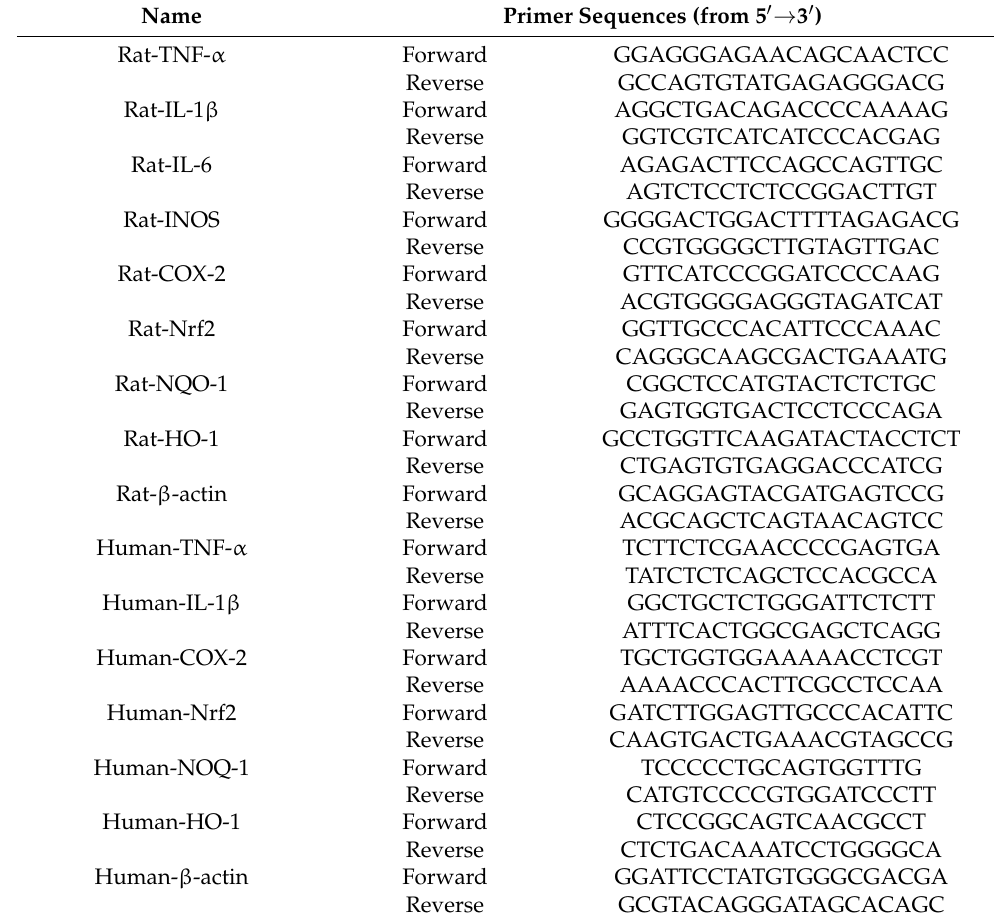
Table 1. Primer sequences used in